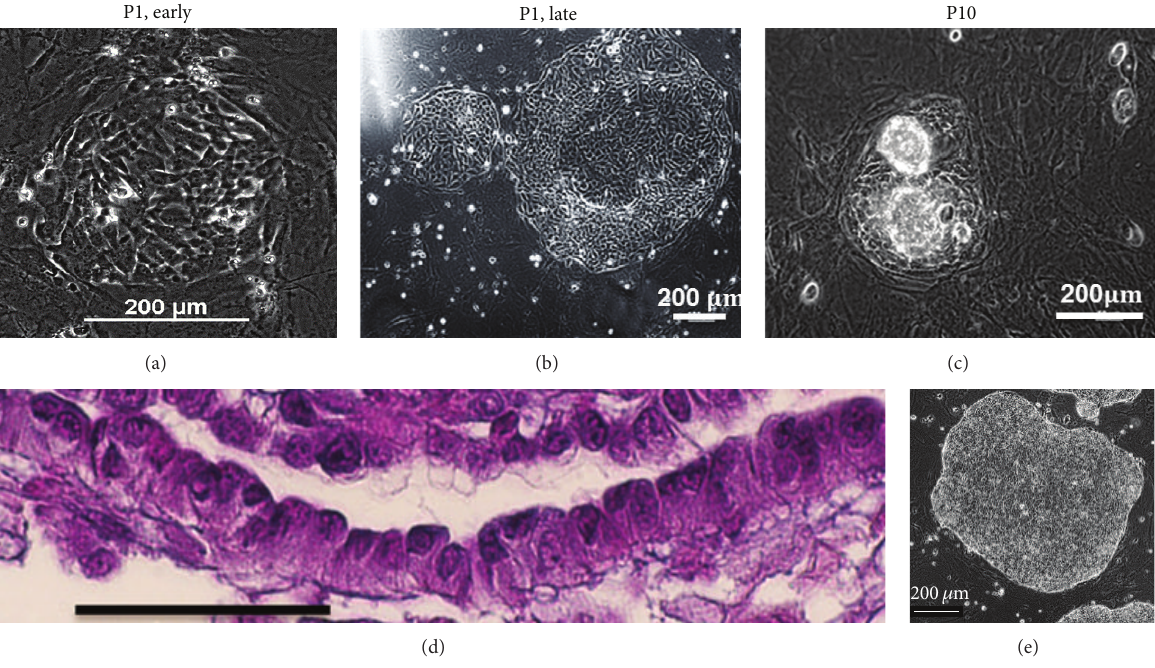
Figure 1: Morphology of ovarian cell colonies (OCCs). (a–c) Morphology of cell colonies in the first passage and in higher passages. (d) H&E staining of cross sections of colonies. Cells have an epitheloid morphology with rather apical nuclei. (e) Morphology of a marmoset monkey ES cell